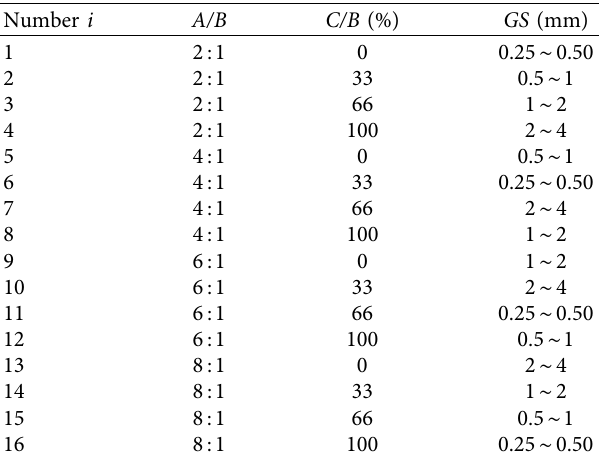
Table 3: Orthogonal experiment